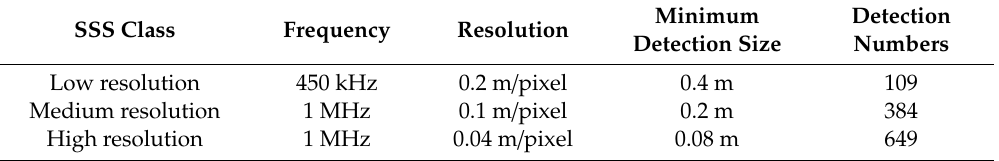
Table 2. Minimum sizes for detection and counts of boulders for the di ff erent levels of SSS